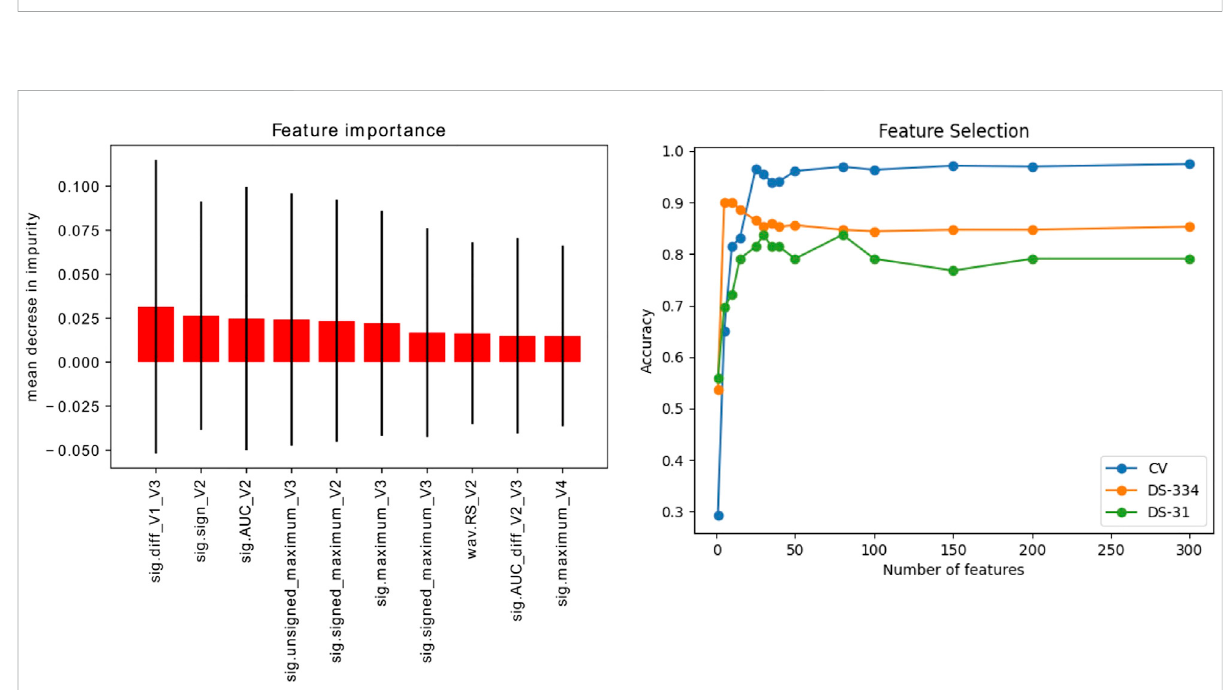
FIGURE 7 (A) Sample importance obtained using raw down-sampled signals; (B) Ten samples (red and blue dots) corresponding to signal time intervals obtained from a subset of V2 signals, together with their corresponding traces (transparent) so that they could be easily interpreted. Red traces correspond to LVOT and blue traces to RVOT.